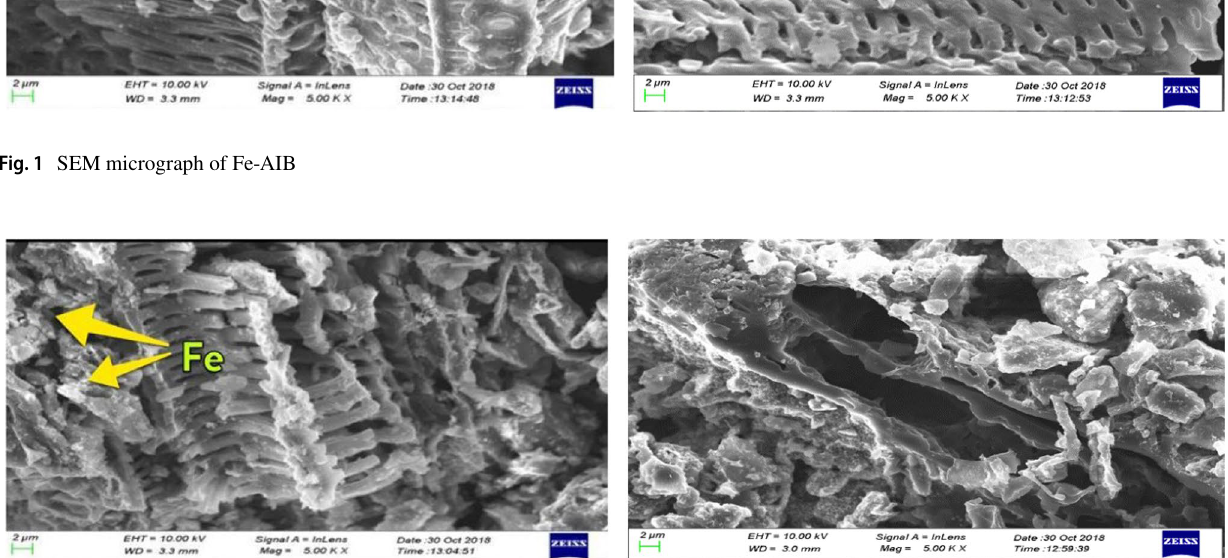
Fig. 2 SEM micrograph of